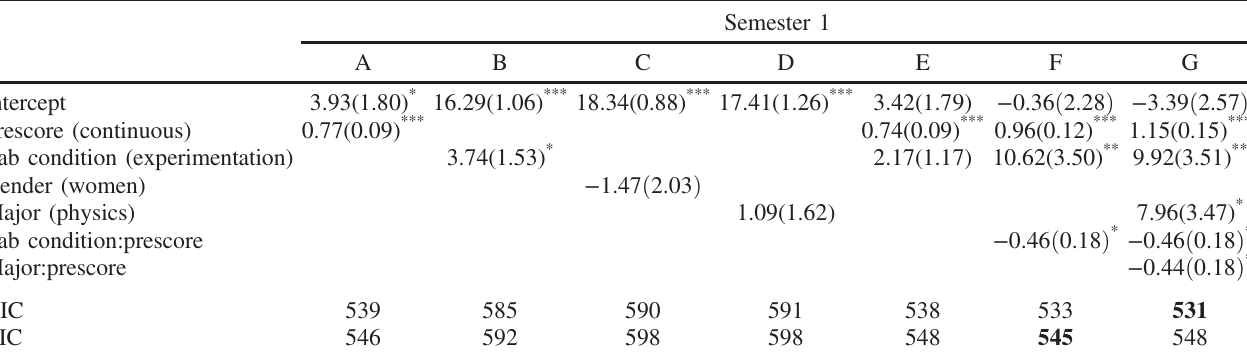
TABLE XII. A selection of models from a forward stepwise regression performed on the E-CLASS data from semester 1 that includes prescore, lab condition, gender, major, and all interactions to predict the postscore. Bold indicates the lowest values for model